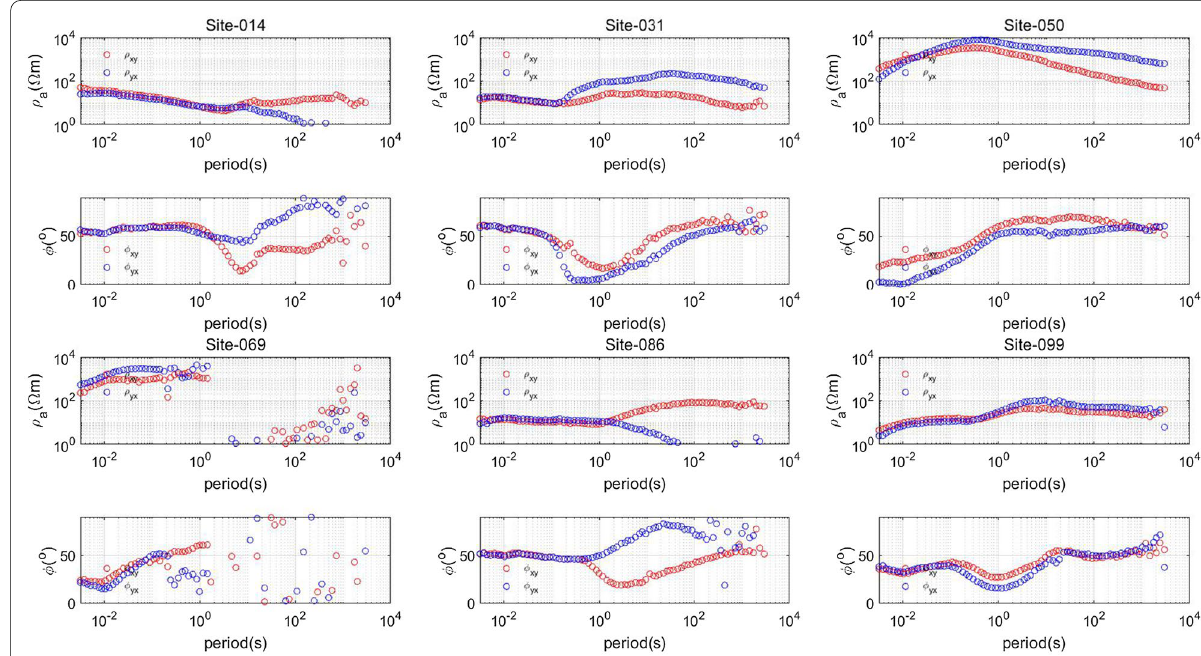
Fig. 2 Apparent resistivity ( ρ a ) and phase ( φ ) curves for typical and original MT sites. The red and blue labels represent the apparent resistivity and phase from the elements of the impedance tensor matrix Z xy and Z yx ,